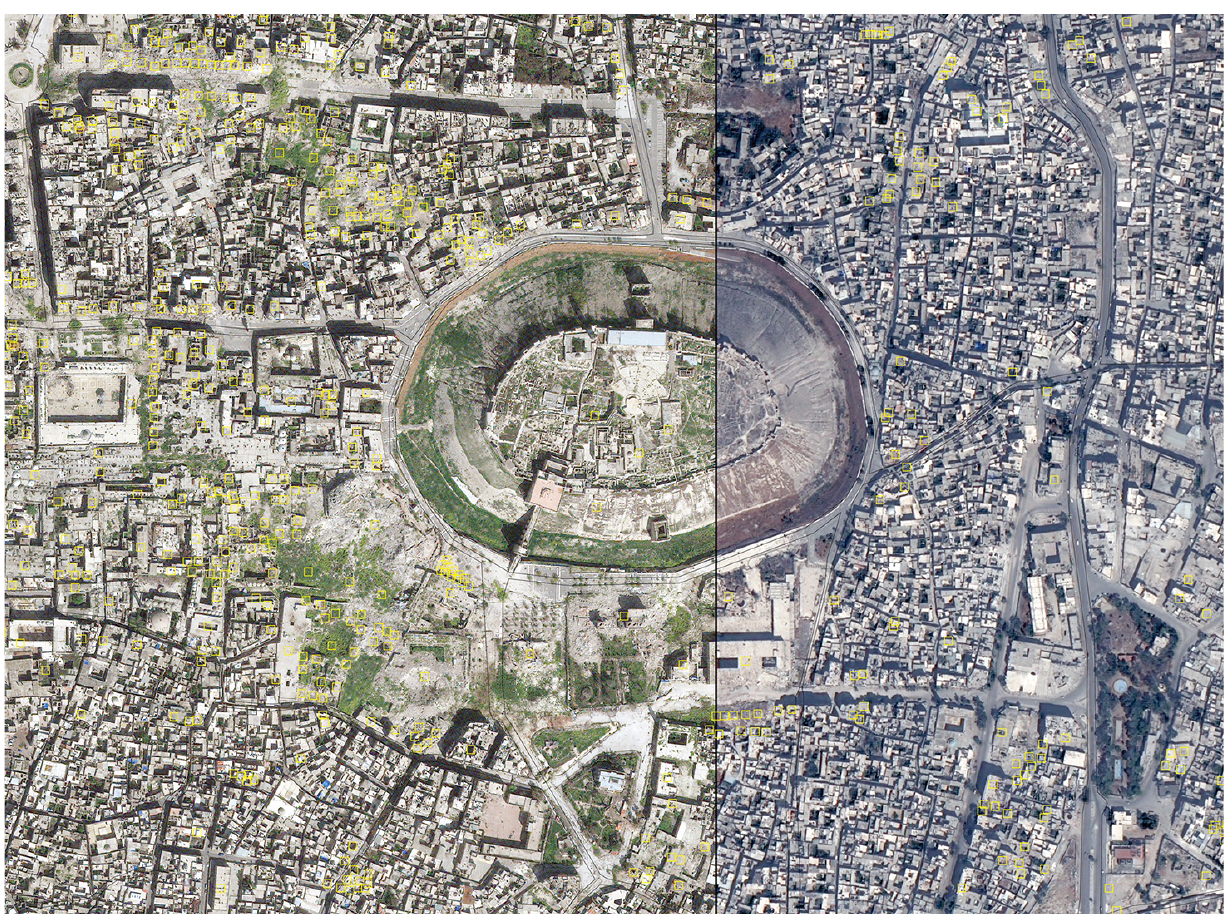
Figure 4. Two satellite images of Aleppo’s Citadel and surrounding neighborhoods on March 23, 2016 (left) and Septem- ber 3, 2015 (right). Yellow squares indicate damaged sites identified by the United Nations in May 2015. Additional un- marked damaged sites are also visible. Satellite images from World View II © Digital Globe 2015 &